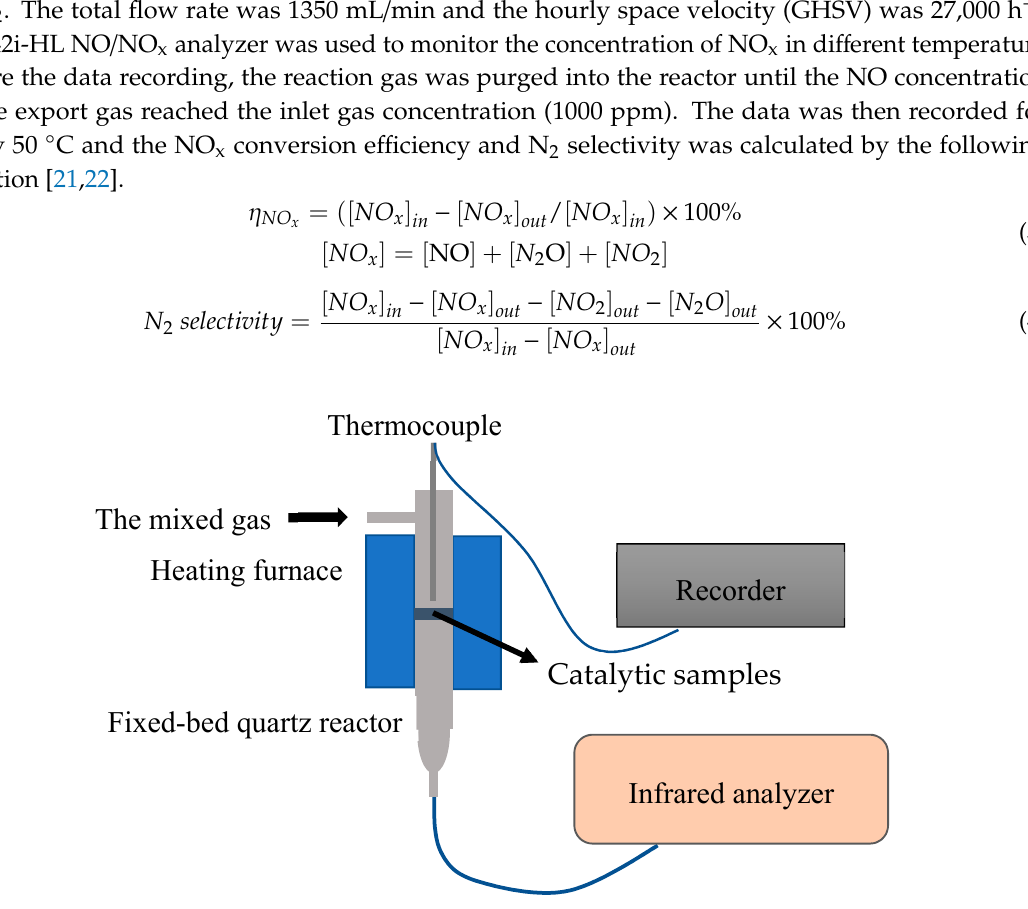
Figure 3. Schematic diagram of the selective catalytic reduction (SCR) testing reactor.